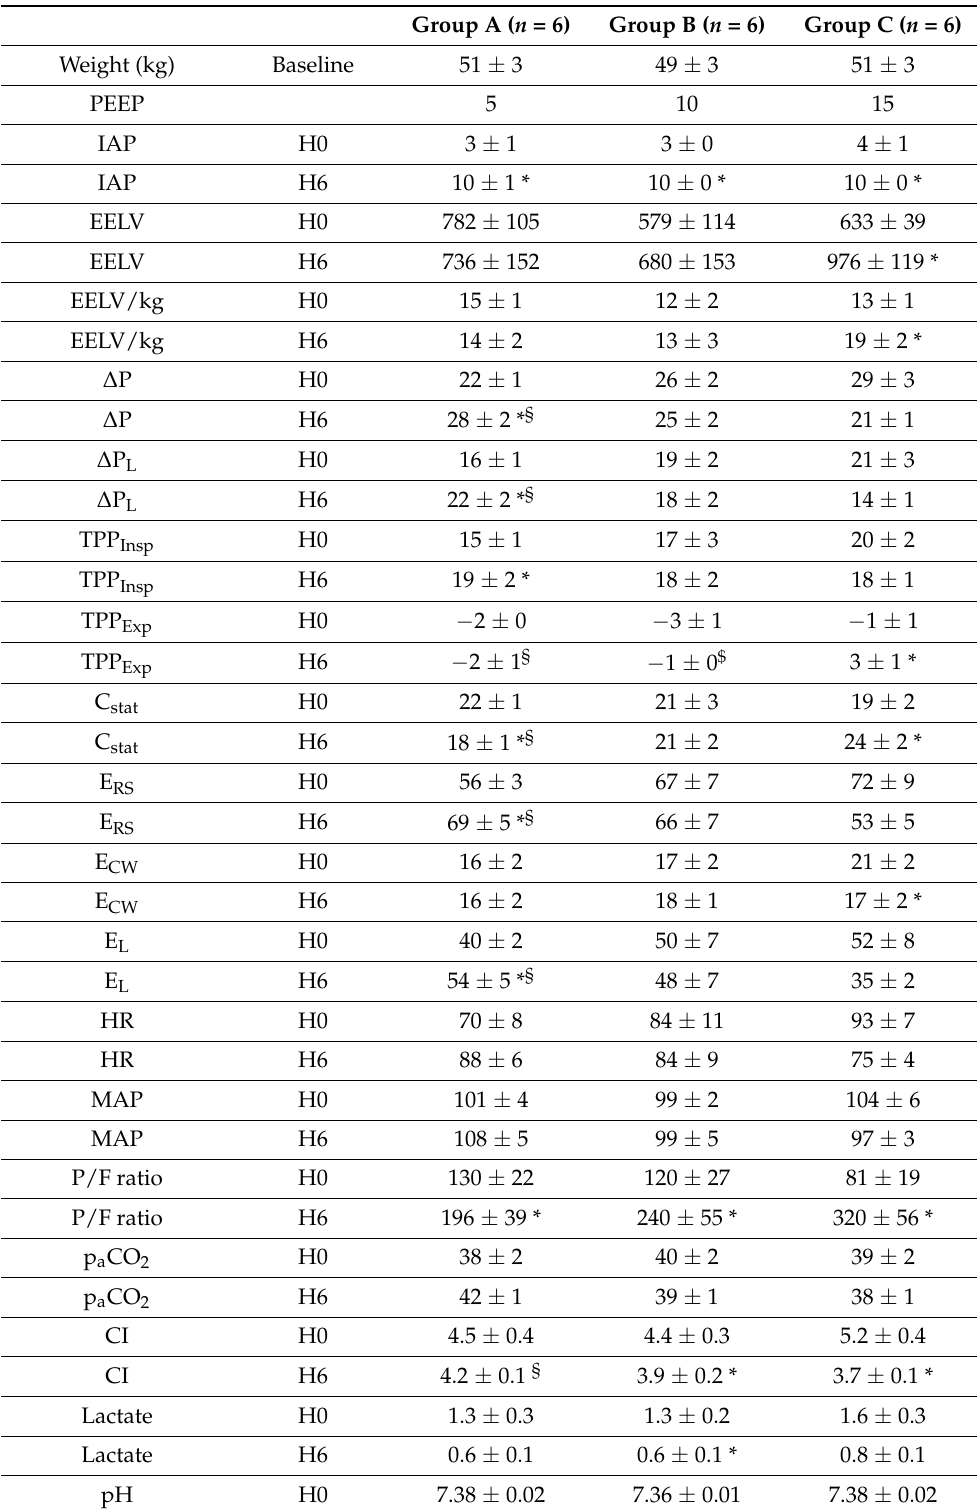
Table 2. Pulmonary and hemodynamic parameters in the setting of 6 h of mechanical ventilation with an intra-abdominal pressure of 10 mmHg and acute lung